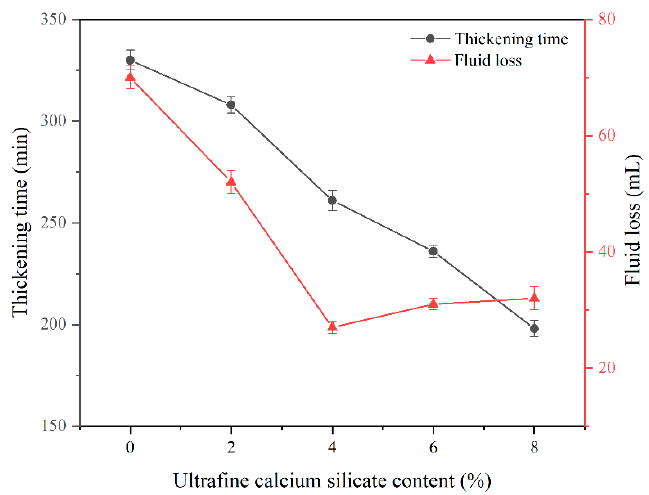
Figure 2. Thickening time and water loss of cement samples.